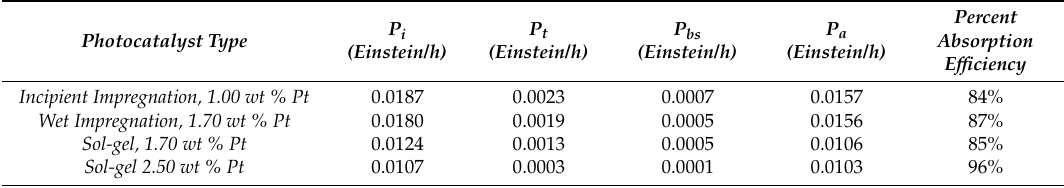
Table 1. Absorbed photon fluxes for the various photocatalysts of the present study. Pi , represents the incident radiation whereas P t , is the transmitted radiation and P a is the absorbed radiation.